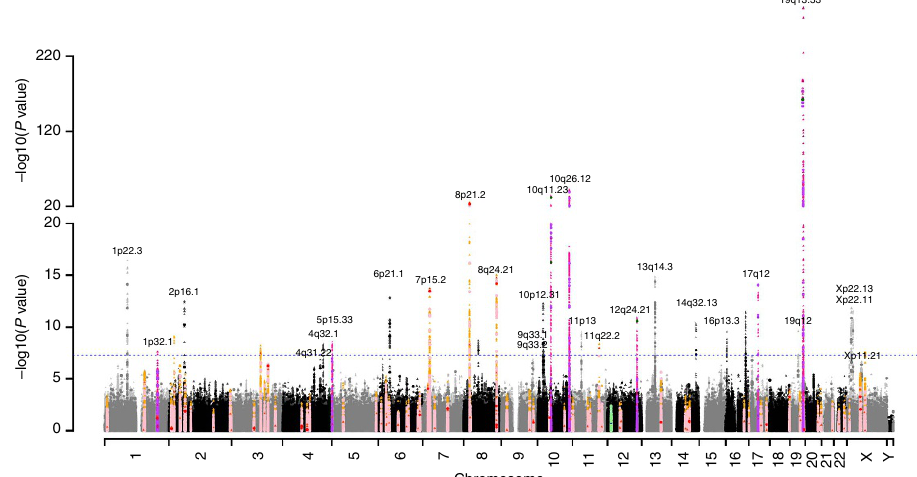
Figure 2 | Results from a GWAS of PSA levels in 28,503 Kaiser Permanente non-Hispanic white non-cases. P values are for variant associations with log-transformed PSA levels, adjusted for age and ancestry principal components using a linear regression model. Black and grey peaks indicate novel findings. Dark purple and magenta indicates previously reported PSA level associated genotyped and imputed hits, respectively, and light purple and magenta indicate those within 0.5Mb of previously reported hits that were replicated at genome-wide significance. Dark pink and red points denote previously reported PCa SNPs genotyped and imputed, respectively, and pink and orange indicate those within 0.5Mb of previously reported PCa SNPs genotyped and imputed. Dark blue and green points denote the previously reported genotyped and imputed, respectively, SNPs associated with PSA levels only (and not PCa), and light blue and green those within 0.5Mb previously reported hits. Circles denoted genotyped SNPs and triangles represent imputed